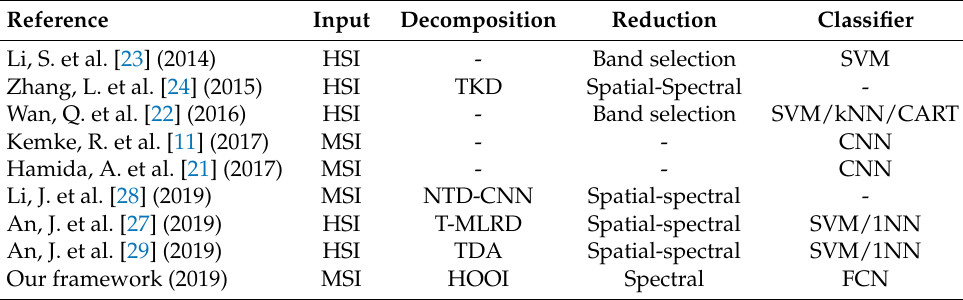
Table 1. Related work in spectral imagery semantic